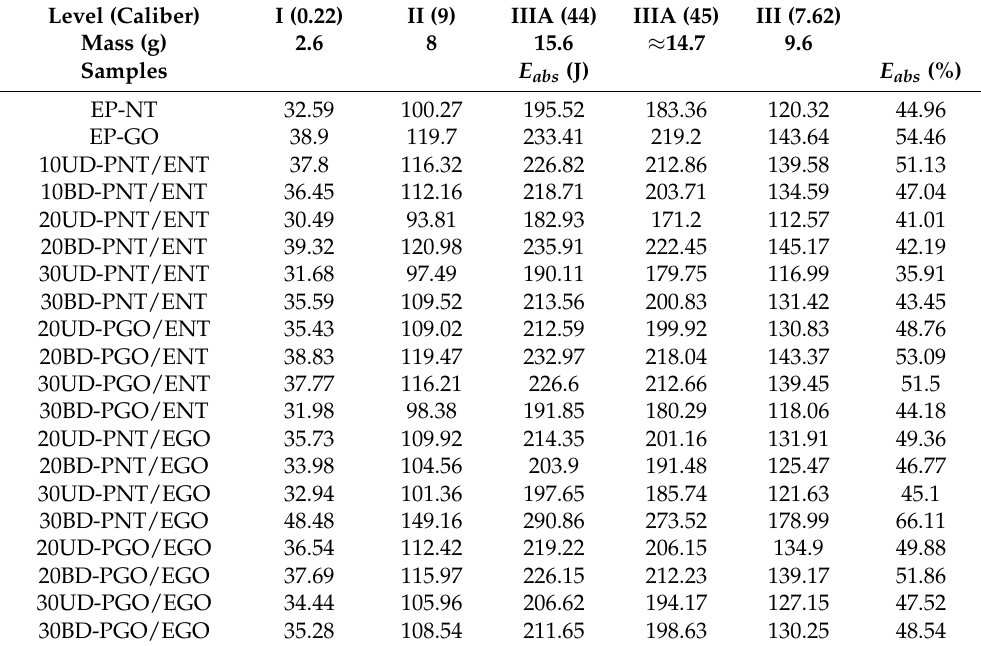
Table 5. Absorbed energy relative to the corresponding projectiles’ masses.